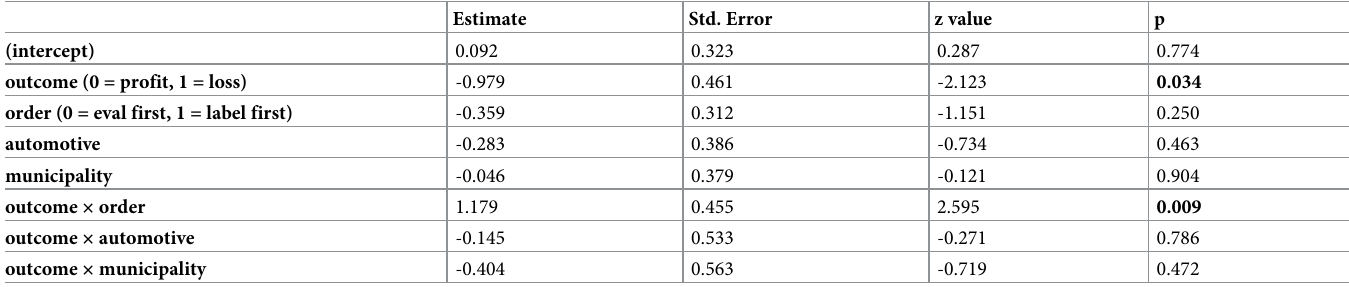
Table 5. Logistic regression with a dummy for label as the dependent variable.